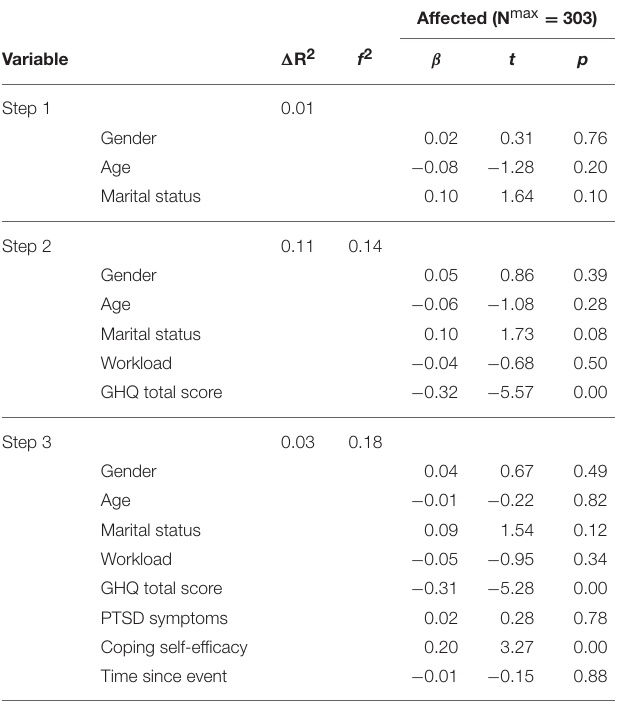
TABLE 7 | Summary of regression analyses for variables predicting job satisfaction in affected